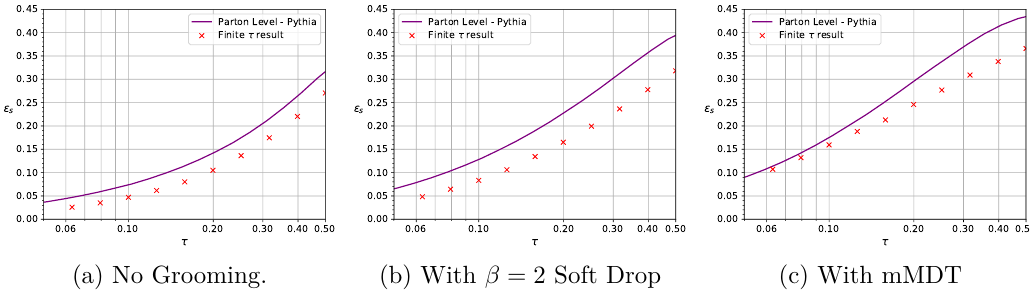
Figure 8. Comparison between our analytic calculation (crosses) and Pythia for the tagged signal distribution as a function of the cut on τ 32 for jets without pre-grooming (left) , with pre-grooming using Soft Drop (centre) and with pre-grooming using the